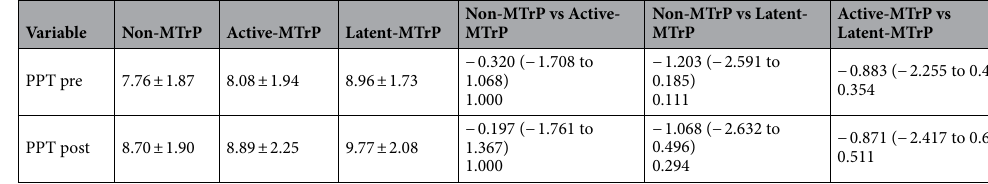
Table 5. PPT expansion. Comparison between groups. Comparison between groups: Difference of means, Confidence interval and P value according to Bonferroni’s correction. *Indicates statistical significance P < 0.05.